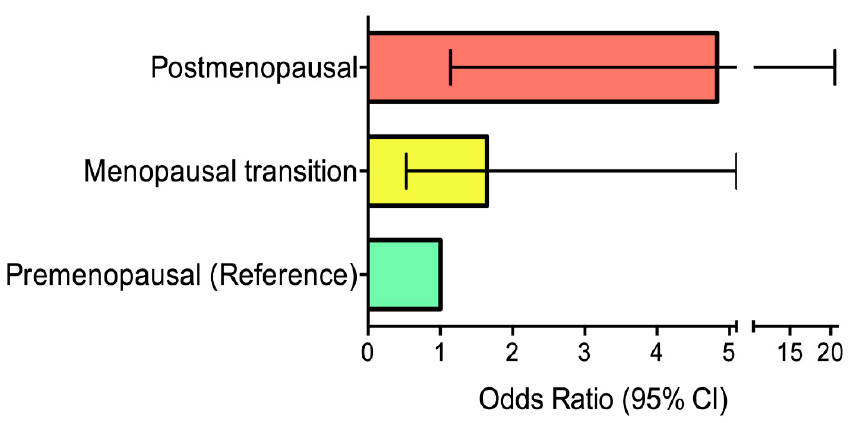
Figure 2. Adjusted odds ratios (with 95% confidence intervals) for central adiposity, defined as waist circumference ≥ 88 cm, in women in the menopausal transition and postmenopausal women. Adapted from [13].